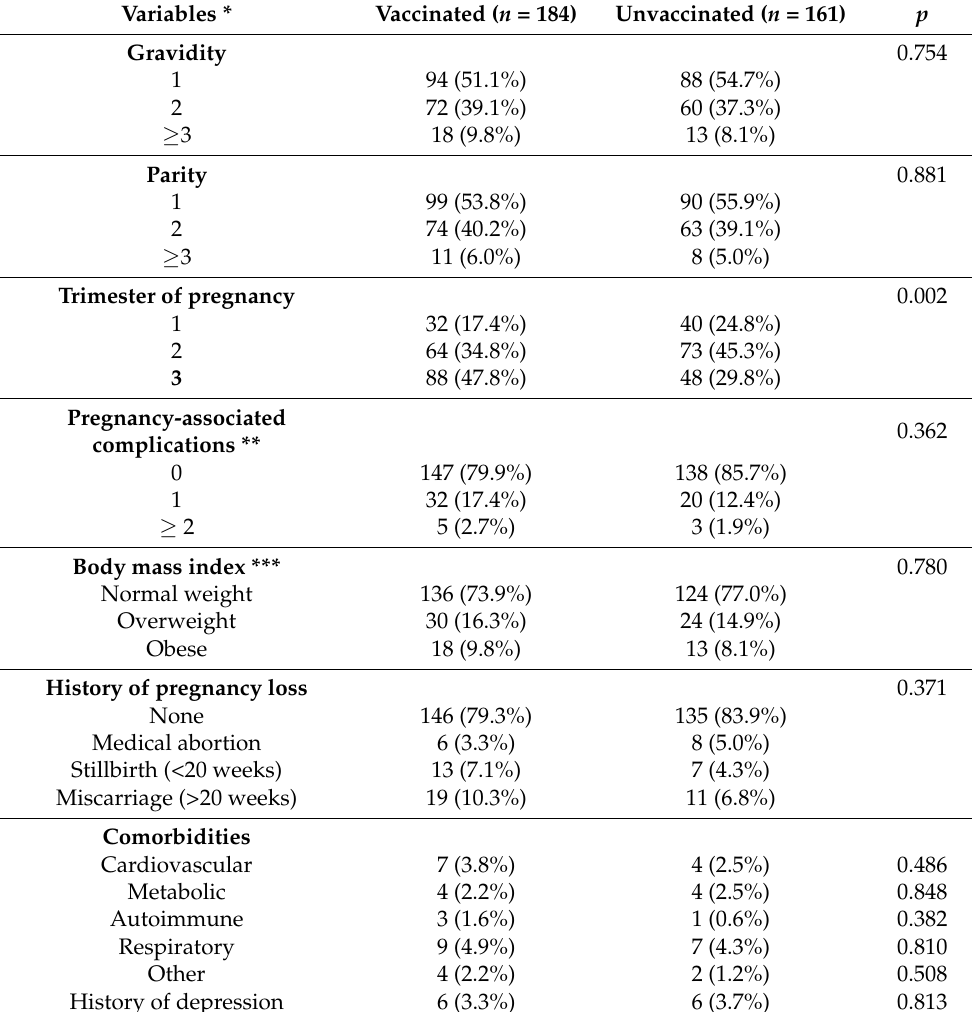
Table 2. Comparison of obstetrical and medical history between vaccinated and unvaccinated pregnant